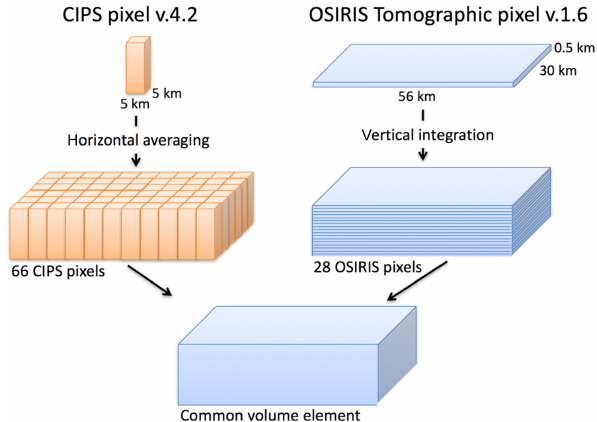
Figure 3. The 3-D common volume is defined by the horizontal extent of one OSIRIS tomographic pixel (56km × 30km) and the vertical range (76 to 90km) of the OSIRIS tomography observa- tions. CIPS pixels have a size of 25km 2 with each side 5km in the nadir. In order to make CIPS comparable to OSIRIS in the CV, 66 CIPS pixels (11 × 6) are averaged over the CV. The tomographic OSIRIS pixels need to be integrated over the column of 28 levels to be comparable to